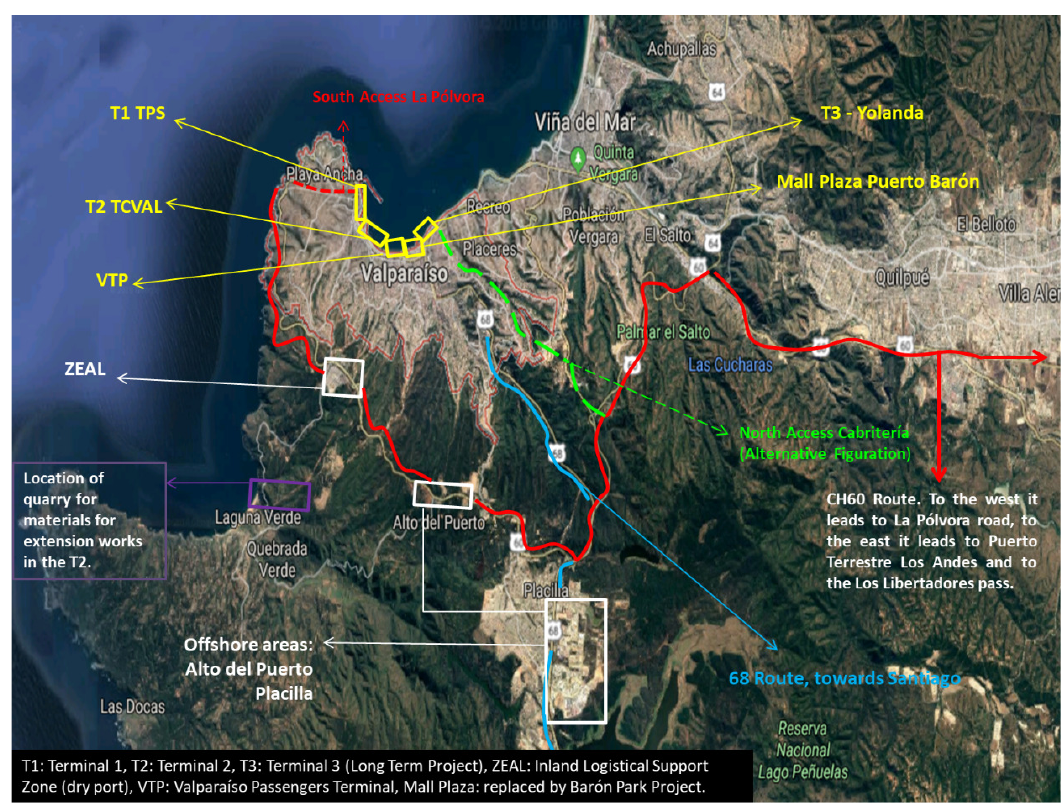
Figure 3. Logistical map of Valparaíso and its hinterland. Source: Own elaboration using Google Earth. visual porosity and functional porosity are very much present in this section of the port separating the two ter‐ minals (Carta, 2012; Ellin, 2006).